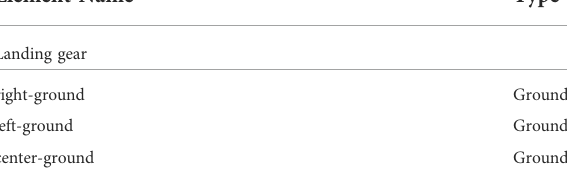
TABLE 3 Ground Elements for the Landing Gear of the generalised Hawk T.